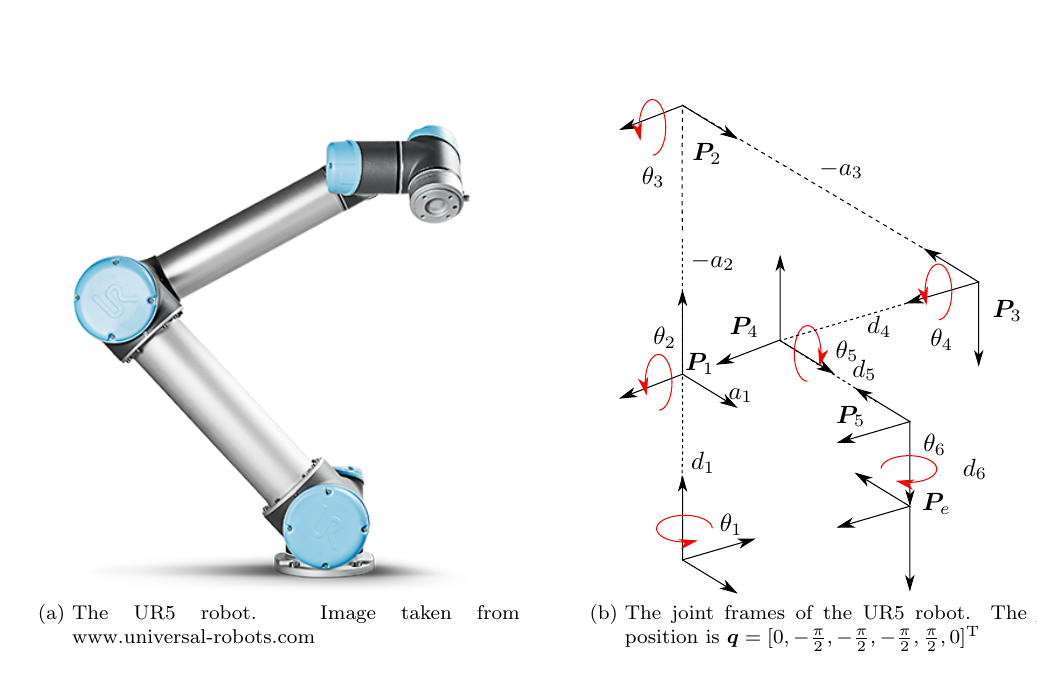
Figure 6: Overview of the UR5